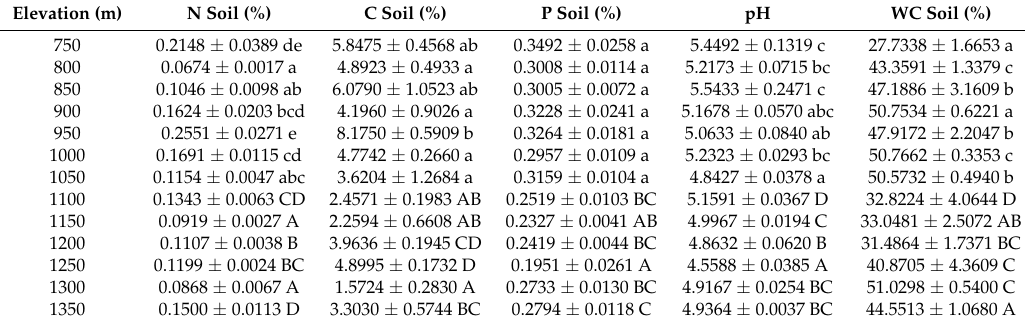
Table 2. General description of soil properties at various elevations on Changbai